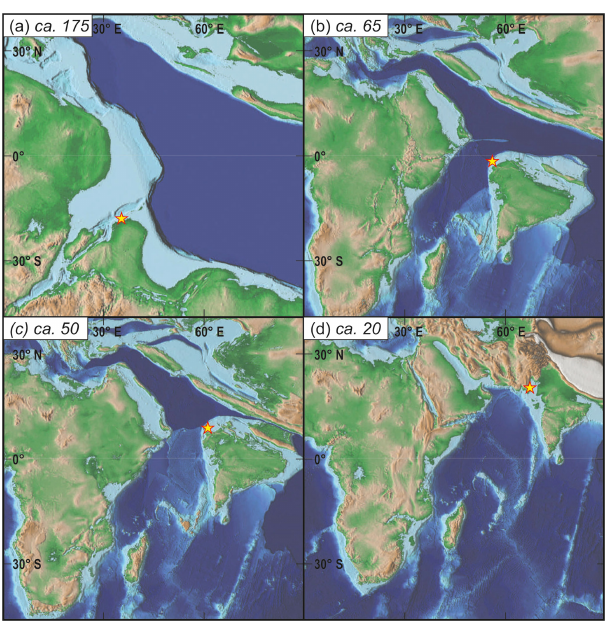
Figure 5. Paleogeographic evolution of the study area as part of the Indian Plate since the Jurassic. (a) Jurassic, ca. 175 million years; a rift evolves northwest of the approximate study area lo- cation (star; map from Scotese, 2014a). (b) At ca. 65 million years, Cretaceous–Paleocene, drifting northward. A strip of emergent land (likely an intra-oceanic arc) is visible north of the approximate study area location (map from Scotese, 2014b). (c) At ca. 50 mil- lion years, Eocene, post-ophiolite obduction, but pre-collision with Eurasia (map from Scotese, 2014c). (d) At ca. 20 million years, Miocene, early collision stage with flexural foreland stage (map from Scotese, 2014c).All background images (a) – (d) copyright by the PALEOMAP Project/Christoopher R.